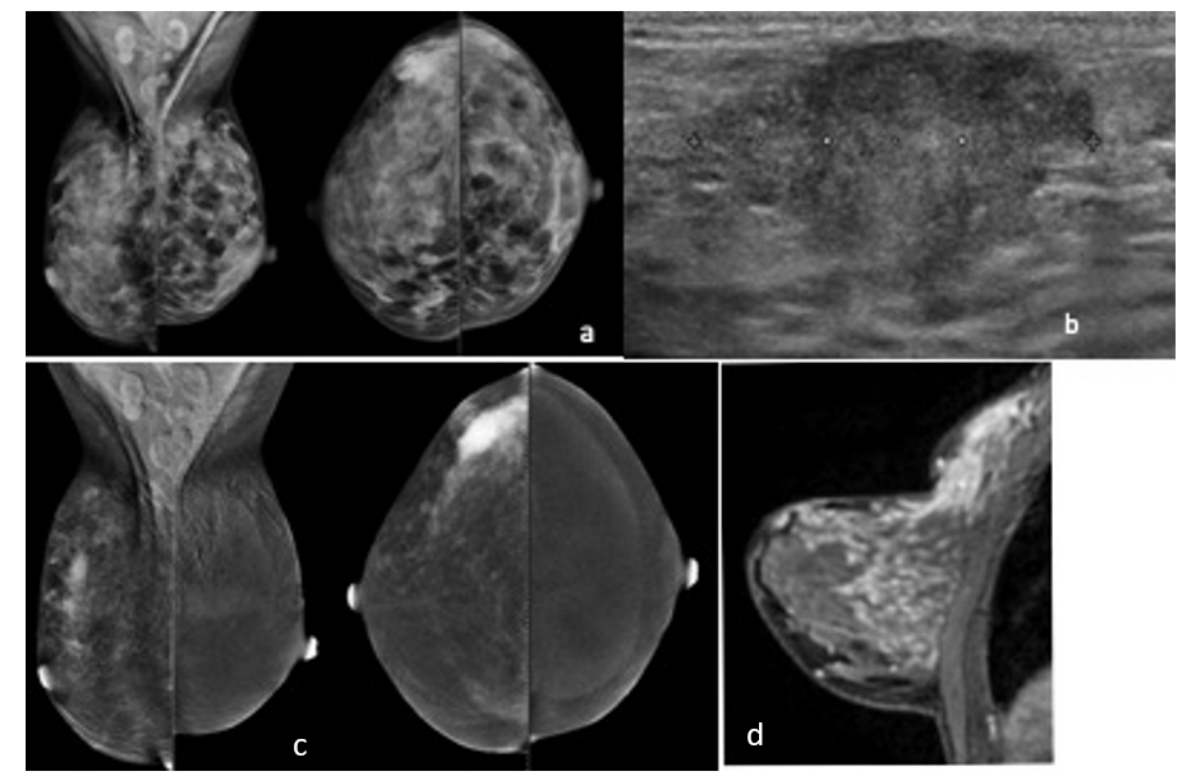
Table 7. Results on the inter ‐ observer agreement calculated on the findings of the two readers.